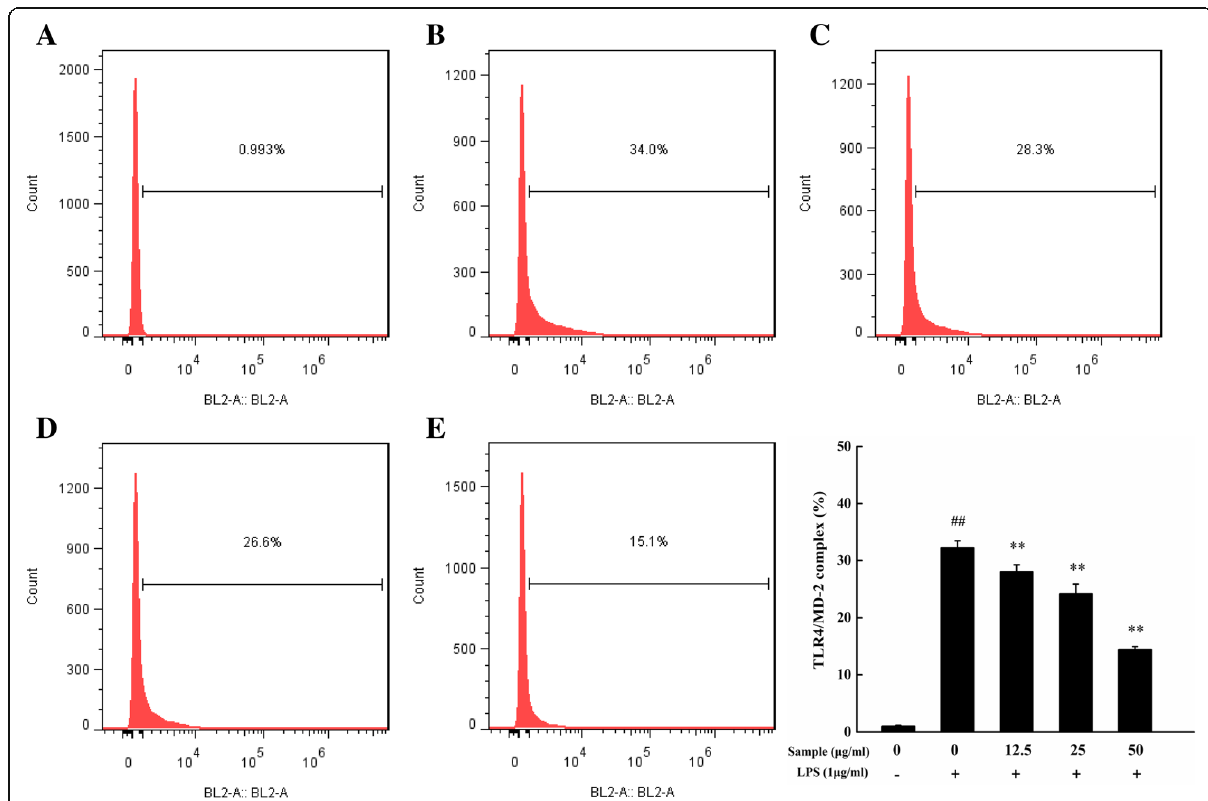
Fig. 4 Flow cytometric analysis for TLR4/MD-2 complex. Cells were treated with YYHs and LPS (1 μ g/mL) for 18 h. And TLT4/MD-2 complex was detected with FCM by PE conjugated mAb TLR4/MD-2 complex antibody ( a , blank group; b , LPS group; c - e , 12.5 – 50 μ g/mL YYHs group). Compared with the control, # P < 0.05, ## P < 0.01. Compared with LPS group, * P < 0.05, ** P < 0.01